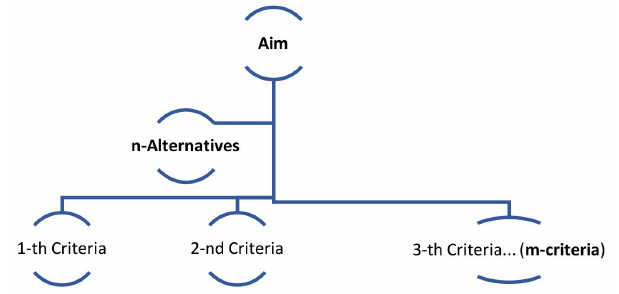
Figure 1. The general form of the decision-making analysis